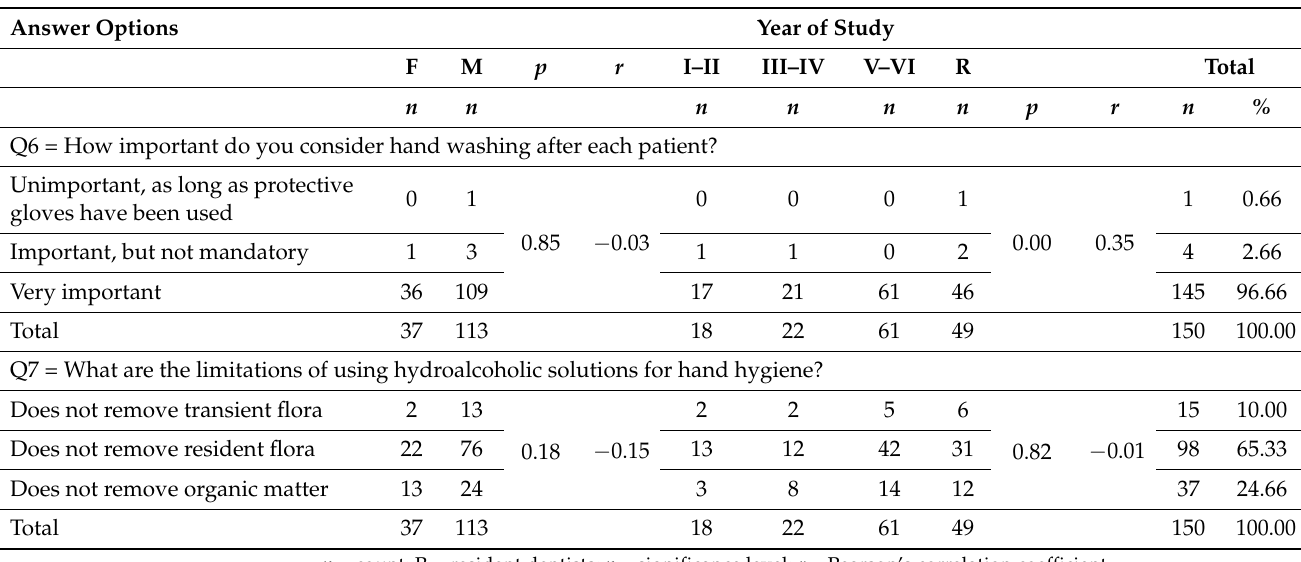
Table 3. Frequency distribution of answers about the importance of hand hygiene and the limitations of using hydroalcoholic solutions by gender and year of